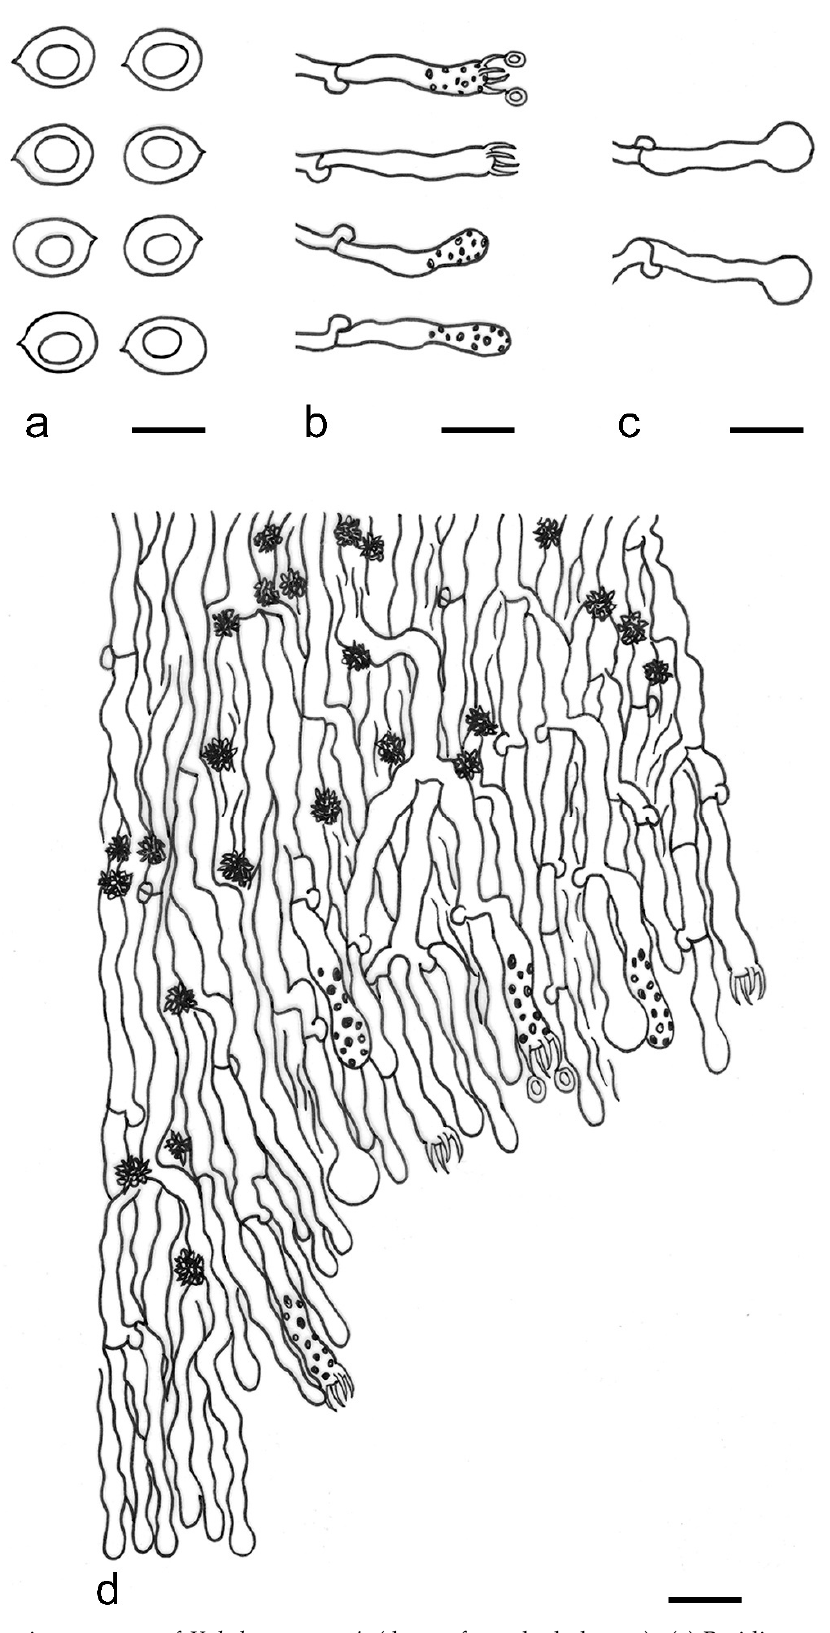
Figure 35. Microscopic structures of Xylodon yarraensis (drawn from the holotype). ( a ) Basidiospores; ( b ) basidia and basidioles; ( c ) capitate cystidia; ( d ) a section of the basidiocarp.—Scale bars: a = 5 μ m; b–d = 10 μ m.